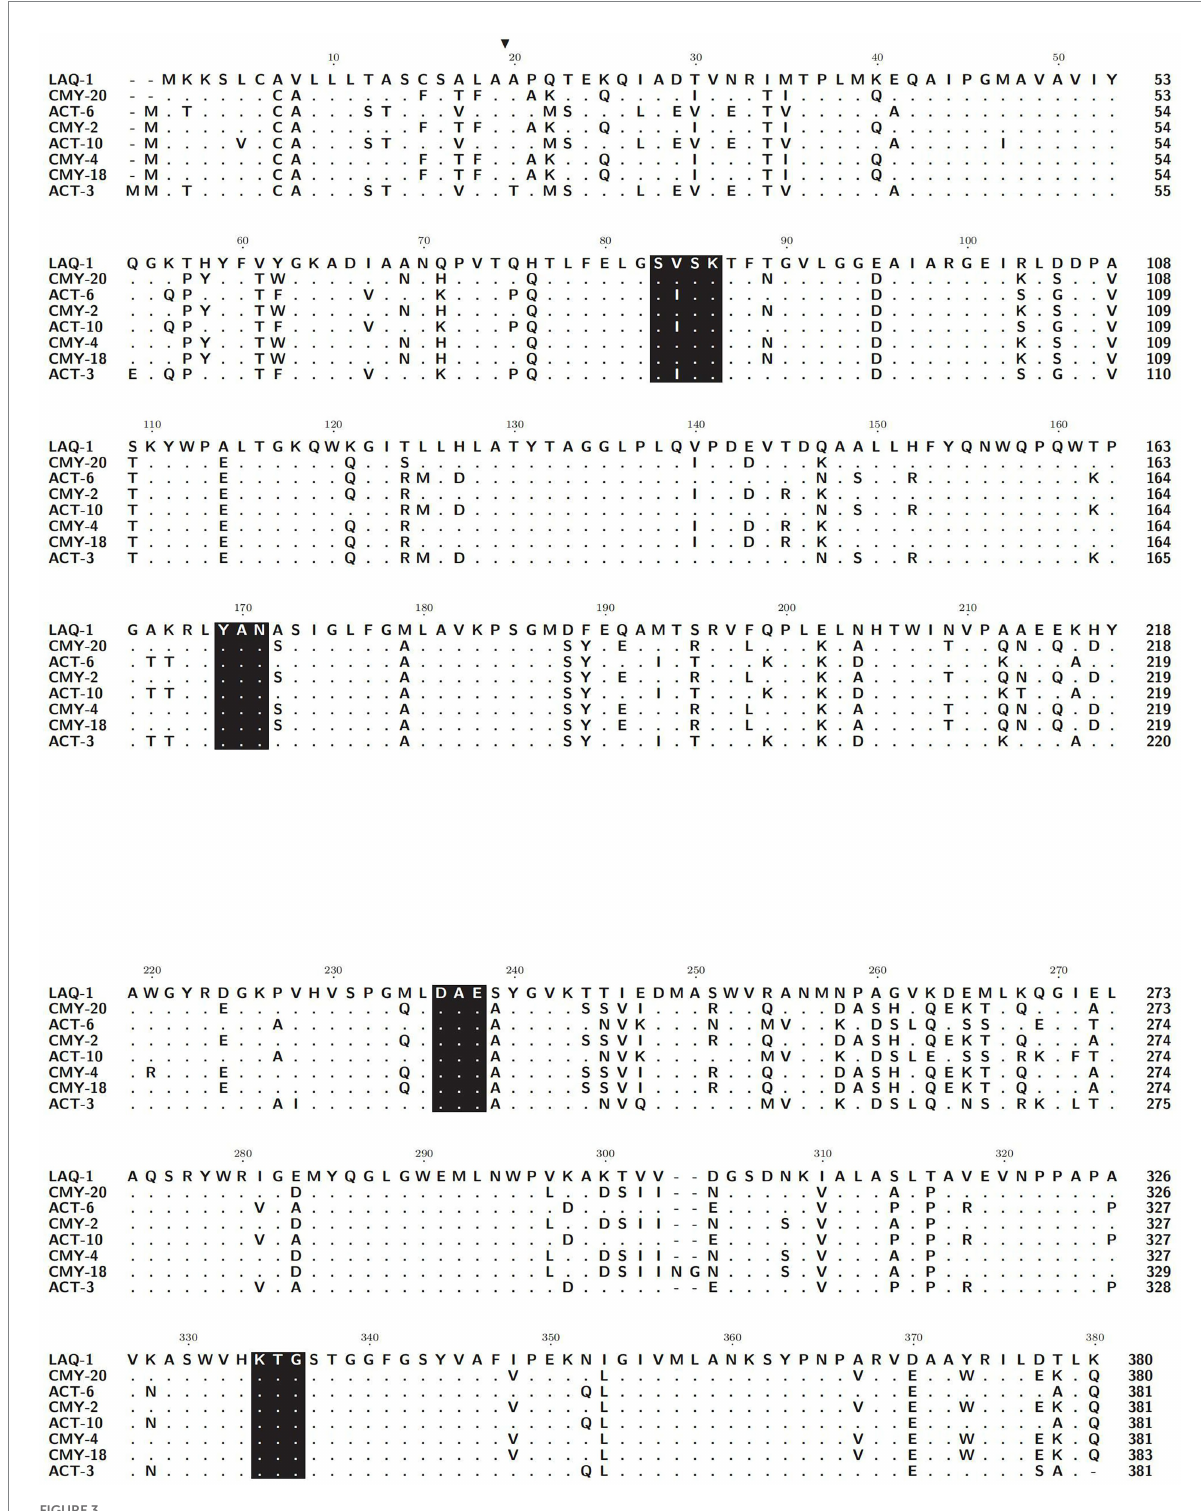
FIGURE 3 Alignment of the amino acid sequences of LAQ-1 and its homologous function-characterized class C β -lactamases. Identical amino acids are indicated by dots. Signal sequences are highlighted in black, and four conserved motifs are shaded in black. LAQ-1 numbering is based on the standard numbering scheme for class C beta-lactamases. The sequences and their accession numbers are CMY-20 (AAX58682.2), ACT-6 (ACJ05686.1), CMY-2 (CAA62957.1), ACT-10 (AEV91214.1), CMY-4 (CAA07695.1), CMY-18 (AAU95778.1) and ACT-10